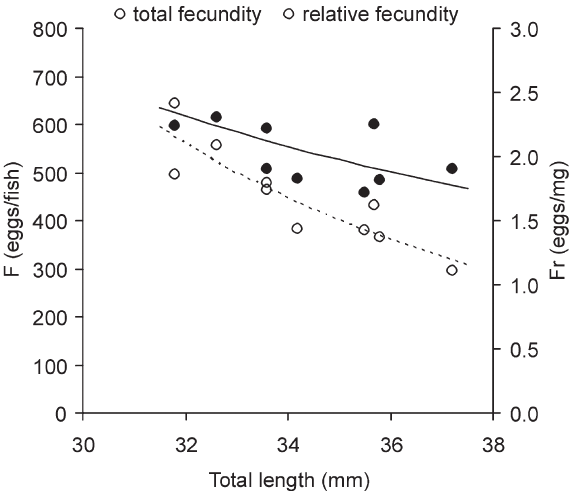
Fig . 3. – Mean (± standard error) monthly hepatosomatic index (HSI) of (a) female and (b) male of Buenia affinis from the Kvarner area.